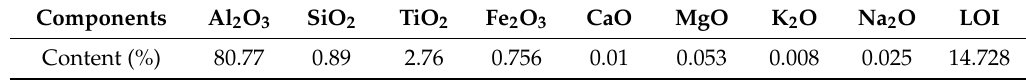
Figure 2. XRD spectra of the diaspore samples. Table 1. Chemical analysis results of the diaspore samples.